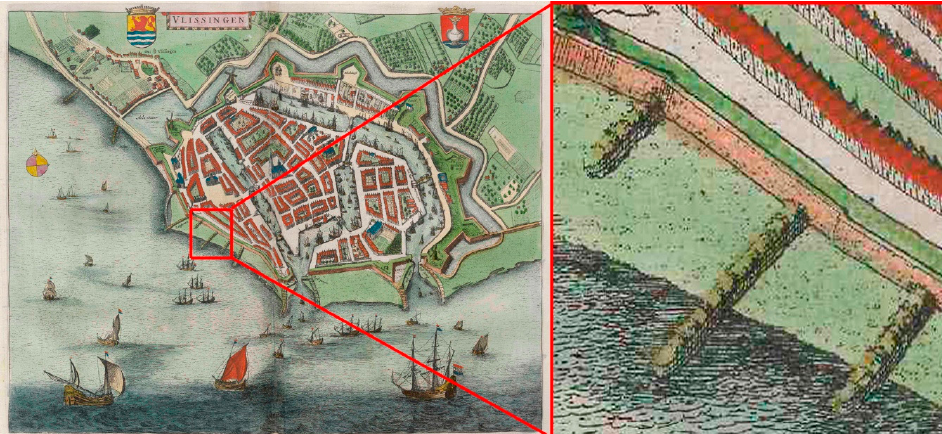
Figure 2. Groins at Flissingen (The Netherlands) in a 1649 map (ed. 1652) by Joan Blaeu [18]. Courtesy Universiteitsbibliotheek Utrecht.